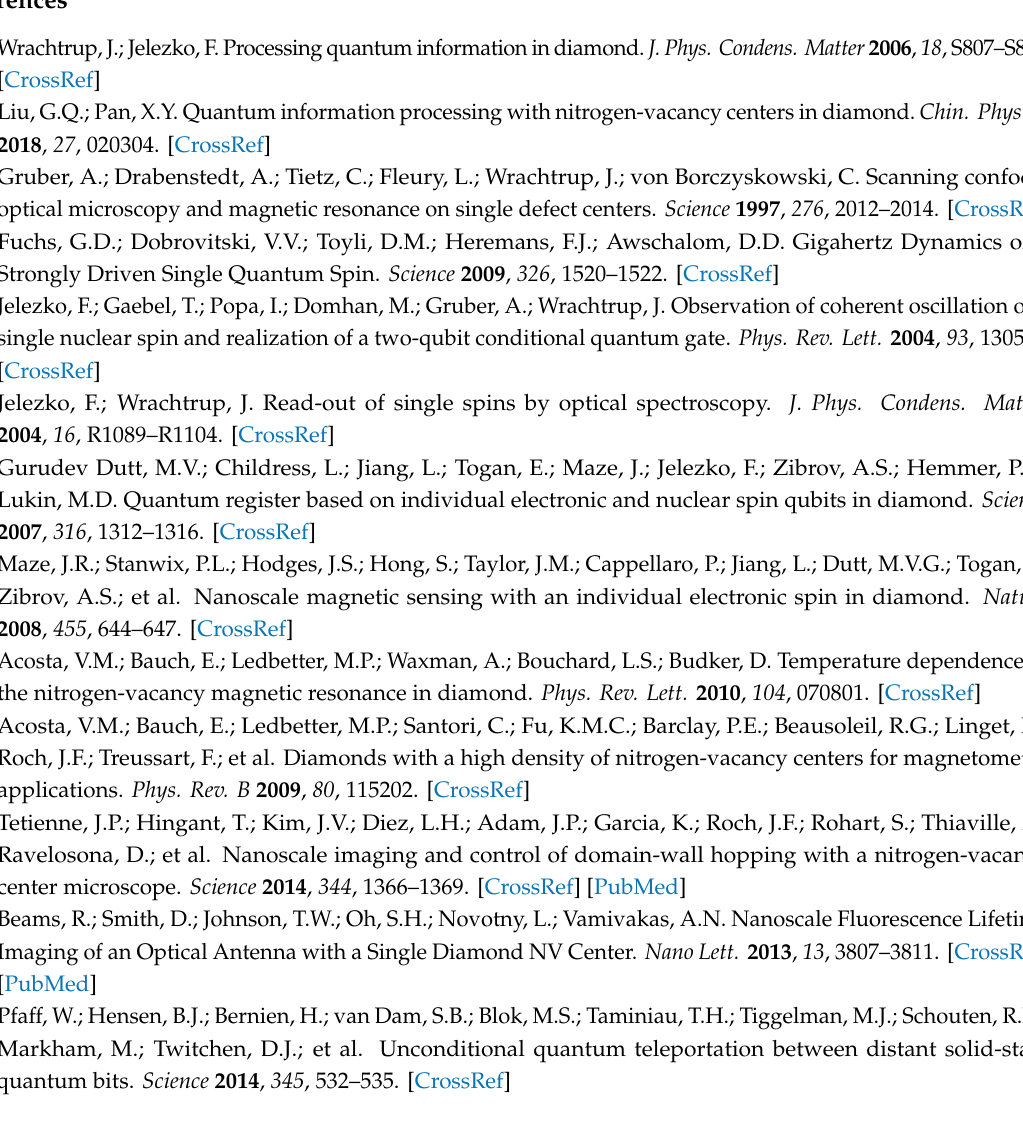
Figure S1: UV-visible spectra of three diamond samples (A, B, C); Table S1: The calculated absorption coe ffi cient and the nitrogen concentrations of three diamond